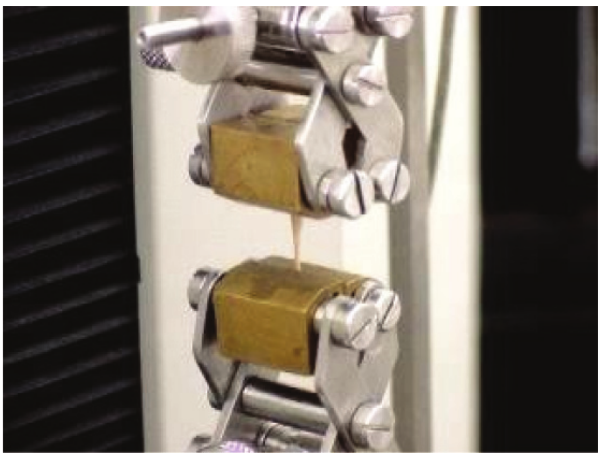
Figure 2 - Primary human tendinae chordae of mitral valve during traction